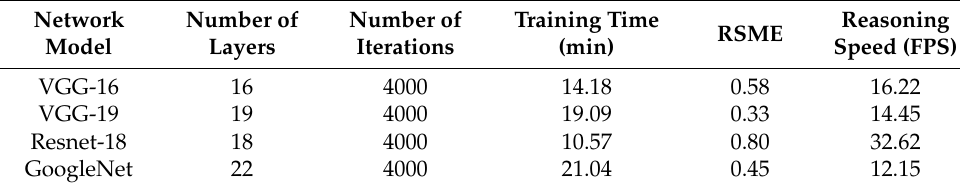
Figure 5. Model comparison results: ( a ) loss curves and ( b ) RMSE curves. Table 1. Performance comparison of different networks.